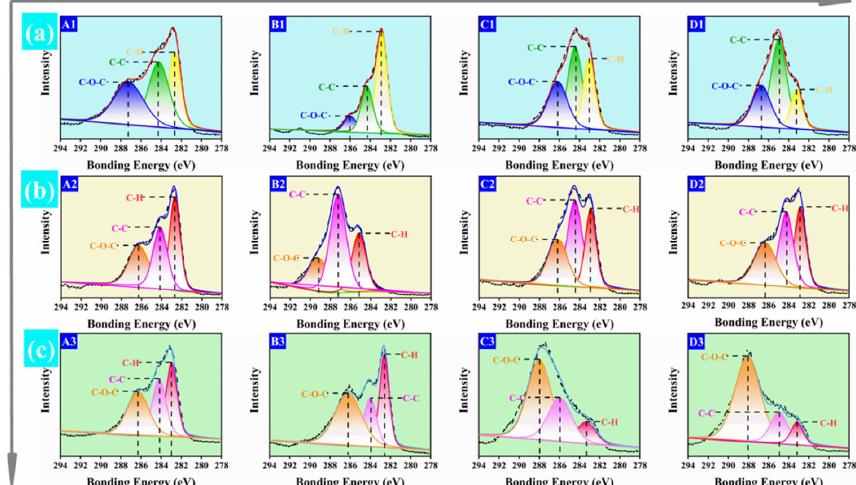
Figure 4. C 1s core ‐ level spectra of ( a ) A1 ‐ pure HPMP, B1 ‐ SDS/HPMP, C1 ‐ SDS/nSiO 2 /HPMP, and D1 ‐ HPMP adhesives. ( b ) A2 ‐ pure SBMP, B2 ‐ SDS/SBMP, C2 ‐ SDS/nSiO 2 /SBMP, D2 ‐ SBMP adhesives. ( c ) A3 ‐ pure CSMP, B3 ‐ SDS/CSMP, C3 ‐ SDS/nSiO 2 /CSMP, and D3 ‐ CSMP adhesives.